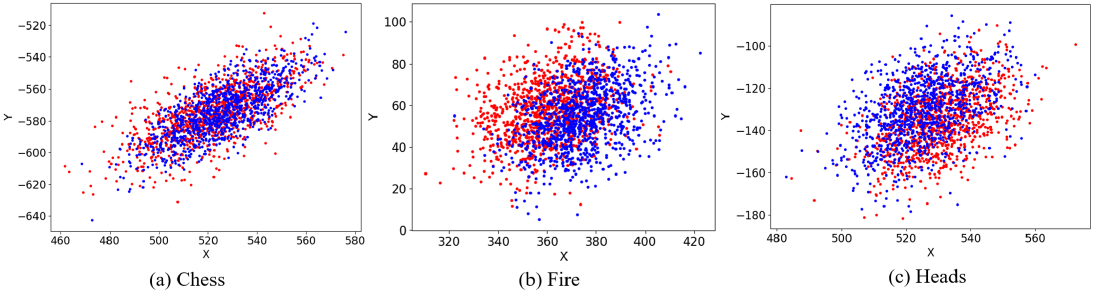
Figure 5. The projection points on the xoy plane. The red points represent the outputs given by the first layer of GoogLeNet Inception V3, which is responsible for pose regression, and the blue points represent the outputs given by the last layer of GoogLeNet Inception V3, which is responsible for image recognition.